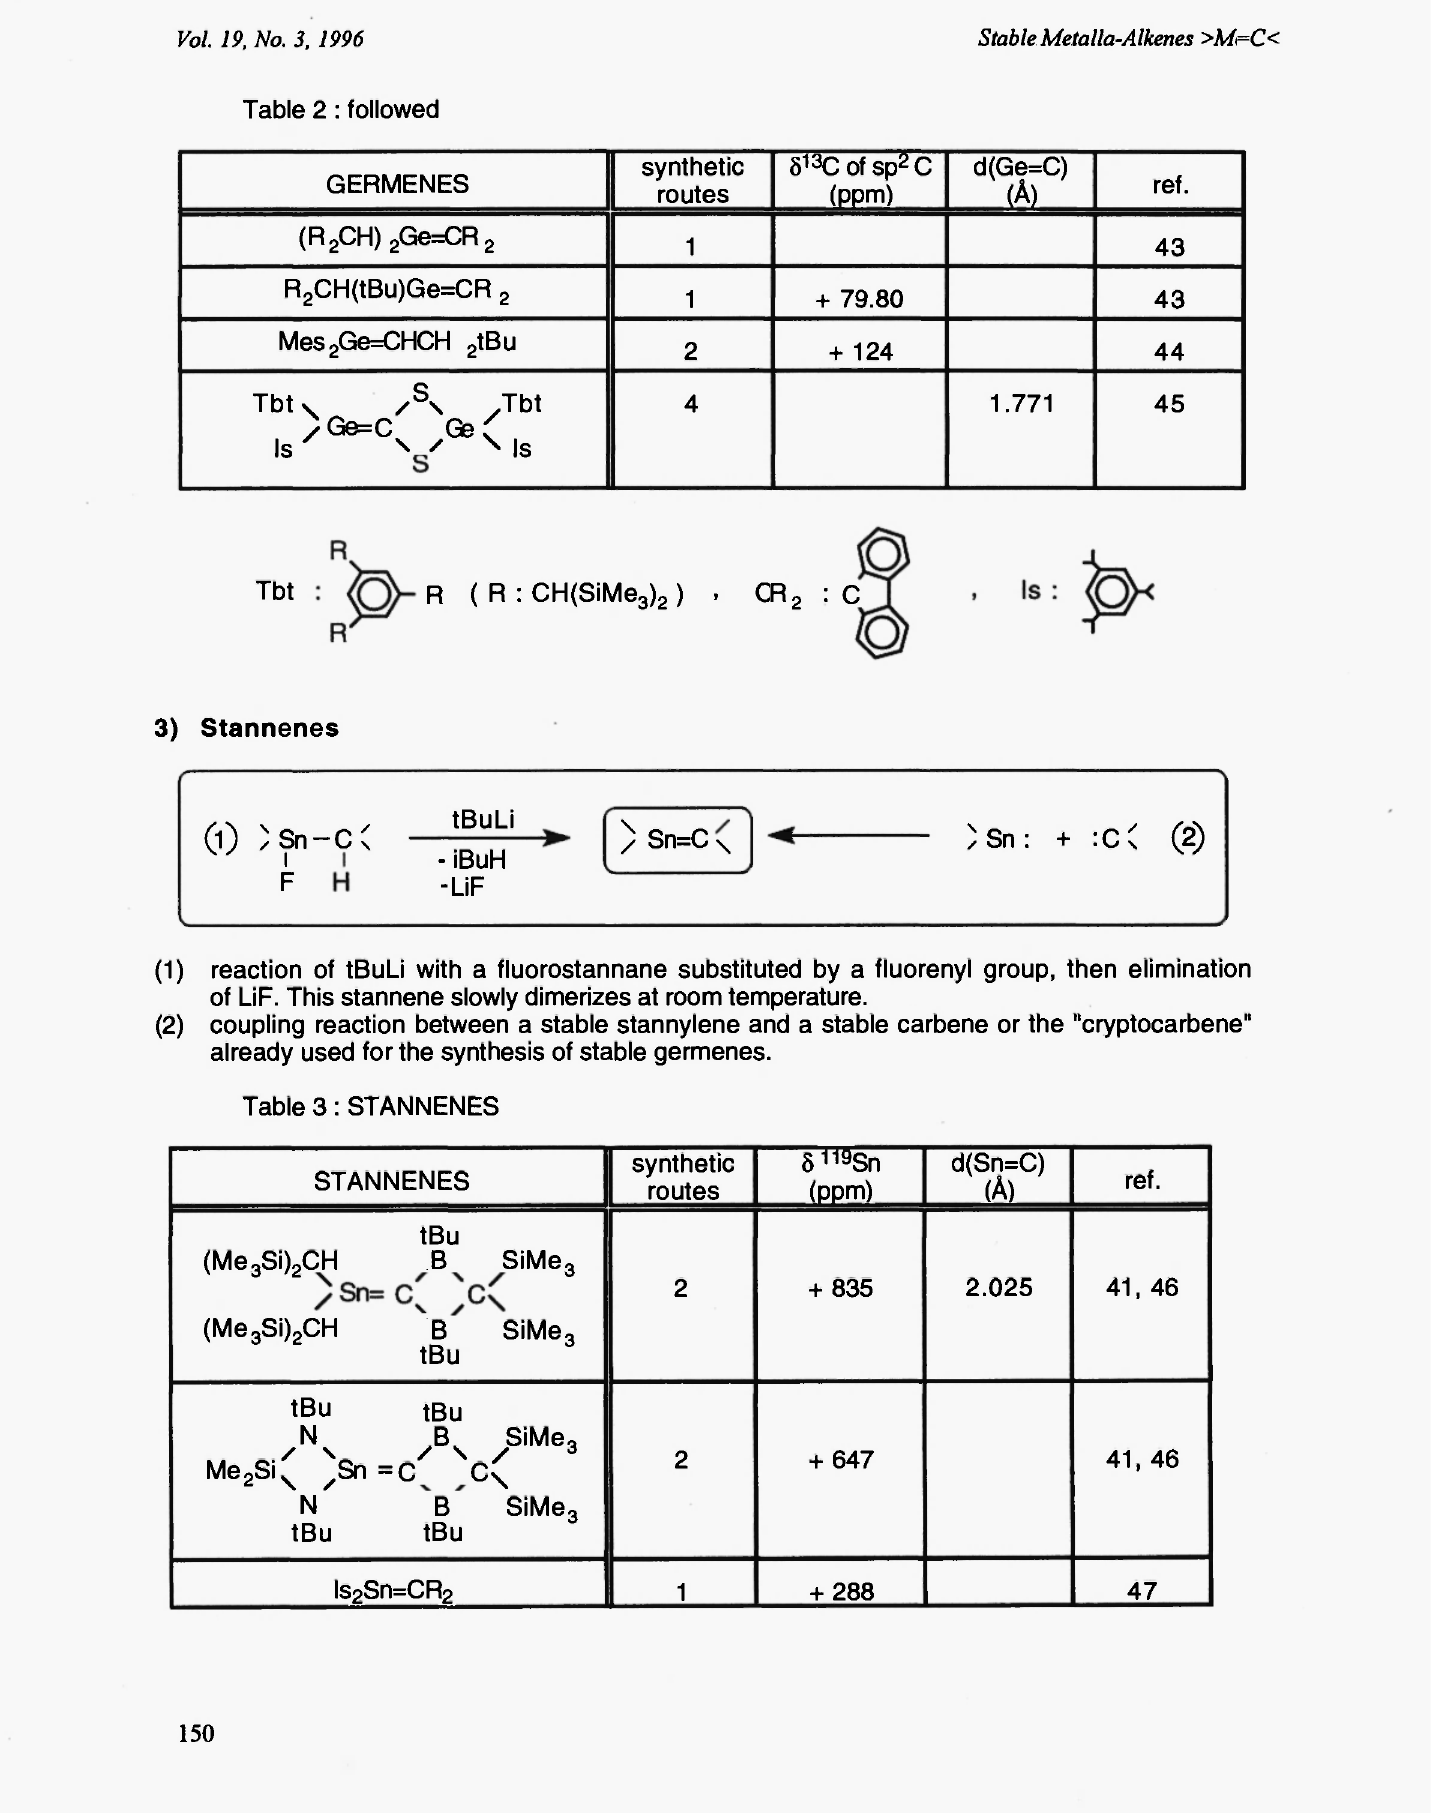
5 13 C of sp 2 C